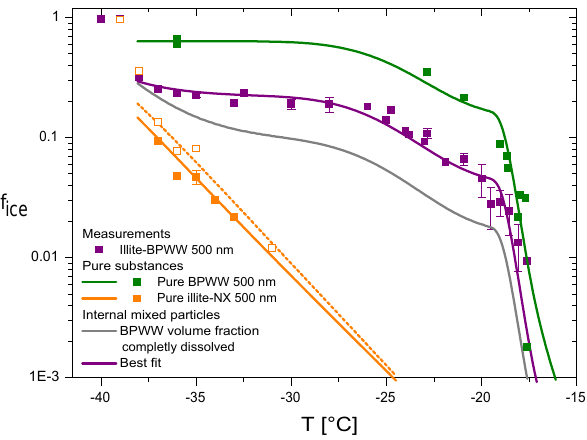
Figure 5. Results of the immersion freezing experiments of parti- cles with a mobility diameter of 500nm generated from the illite– BPWW-suspension as well as from the pure illite-NX and BPWW particles (purple, orange and green symbols, respectively). Filled orange squares: illite-NX particles from suspension, open orange squares: illite-NX particles from dry generation. Error bars are the standard deviation of the experiments and were obtained for tem- peratures with at least three measurements. The green, the dashed orange and the straight orange line represent the freezing ability of pure BPWW, dry generated illite-NX and wet generated illite- NX particles, respectively (500nm mobility diameter) based on the SBM parameters determined from measurements with the pure sub- stances. The grey line represents an extreme case where all the avail- able BPWW material (9 . 7% volume fraction) on the mixed parti- cles has been dissolved in the droplet. The purple line represents the freezing behavior of internally mixed particles which was fitted to the measured